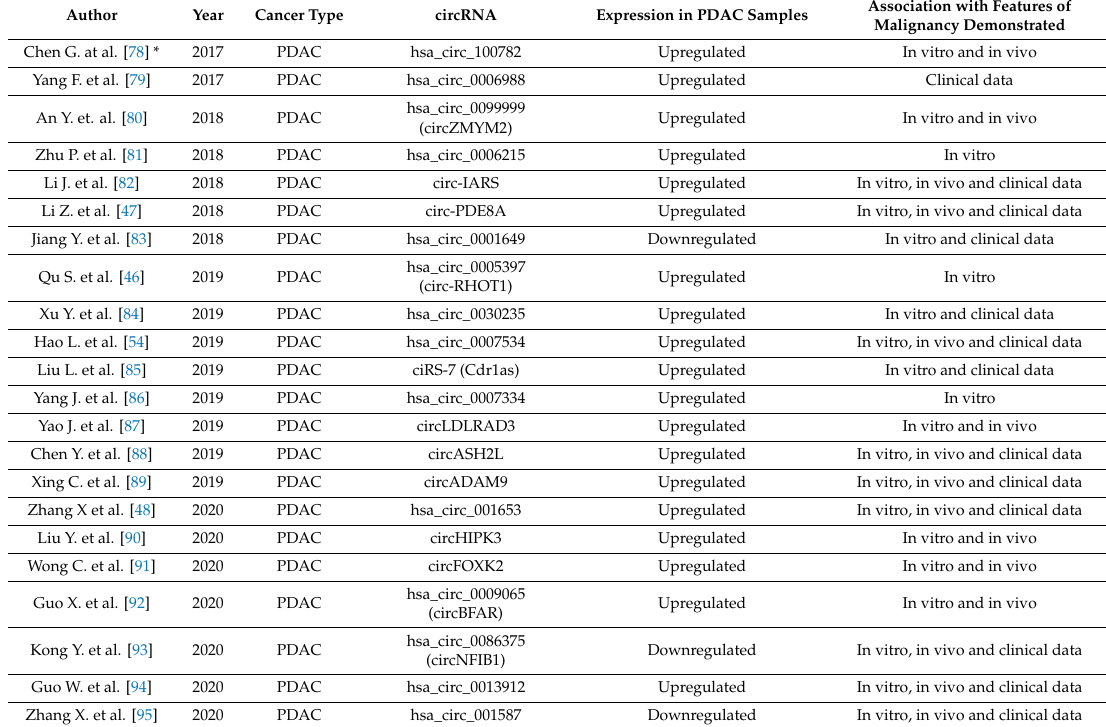
Figure 2. Flow-diagram for study selection. Table 1. Summary of di ff erentially expressed circRNAs evaluated in Pancreatic Ductal Adenocarcinoma (PDAC). * All studies evaluated PDAC patient samples except hsa_circ_100782 which was evaluated in PDAC cell lines